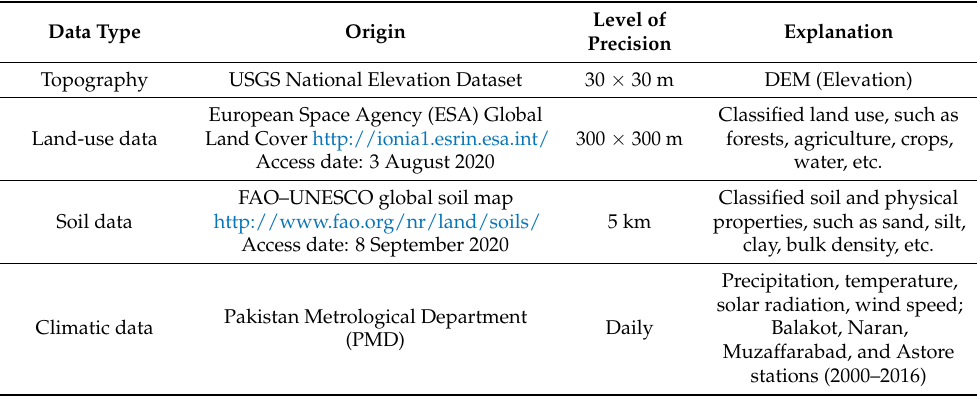
Table 2. List of sources from which data were obtained.